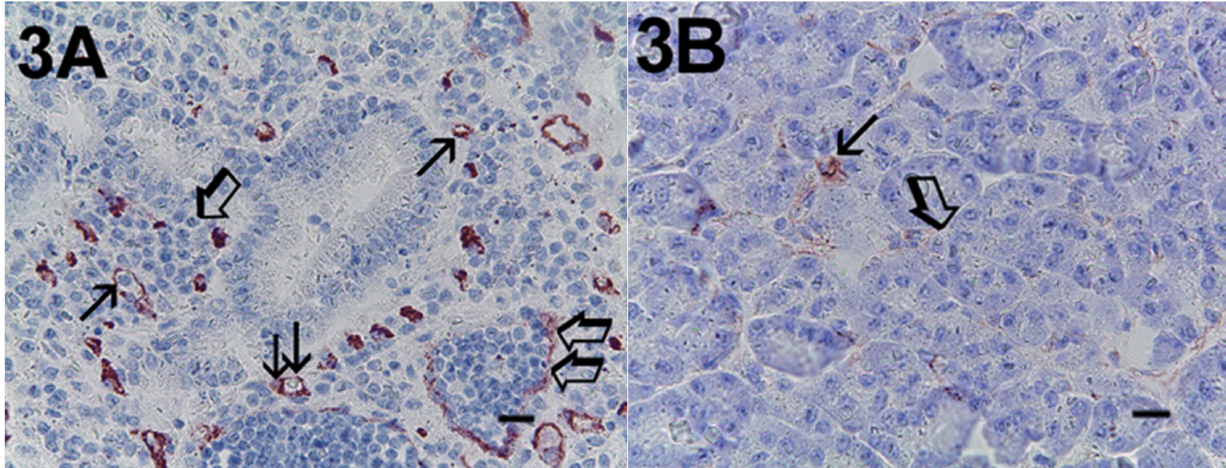
Figure 3. Magnification × 400, 0.19 mm 2 area, immunostaining with the anti-CD31 antibody. ( A ) High MVD in primary PDAT section. Single small arrows indicate single red-stained microvessels. Double small arrows indicate a single red- stained microvessel with a red blood cell in its lumen as a positive internal control. Single big arrows indicate tumour epithelium. Double big arrows indicate a vessel with a lot of tumour cells in its lumen. ( B ) Low MVD in ANT section. Small arrows indicate a single red-stained microvessel. The big arrow indicates normal pancreatic epithelium. Scale bar corresponds to 125 µ m. MVD, microvascular